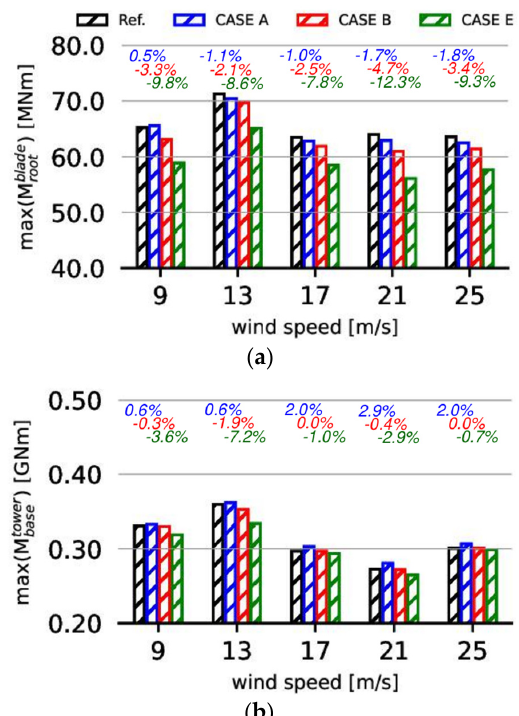
Figure 14. DLC-1.3 ultimate loads vs. wind speed of examined configurations (including safety factors) maximum combined bending moment ( a ) at the blade root and ( b ) at the tower base.